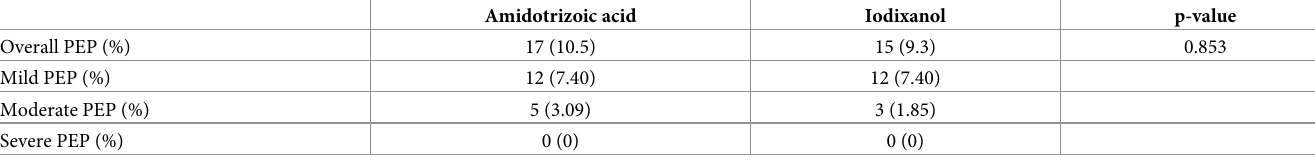
Table 4. The incidence of PEP in the amidotrizoic acid and iodixanol groups after propensity score matching.